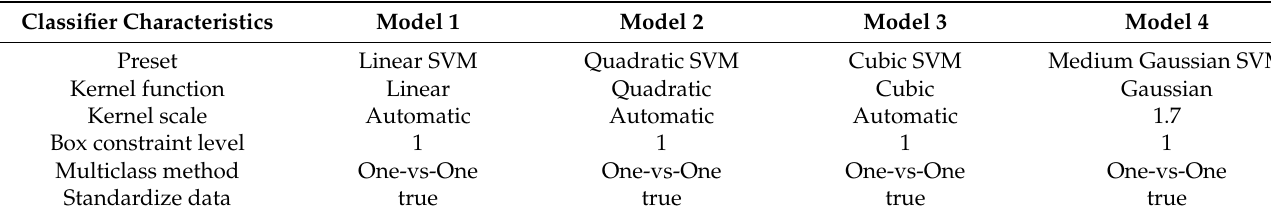
Table 2. Characteristics of SVM classification models.